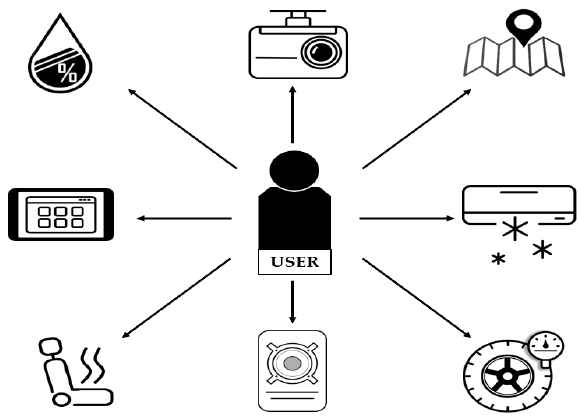
Figure 1. Architecture of the existing in-vehicle infotainment (IVI) system.